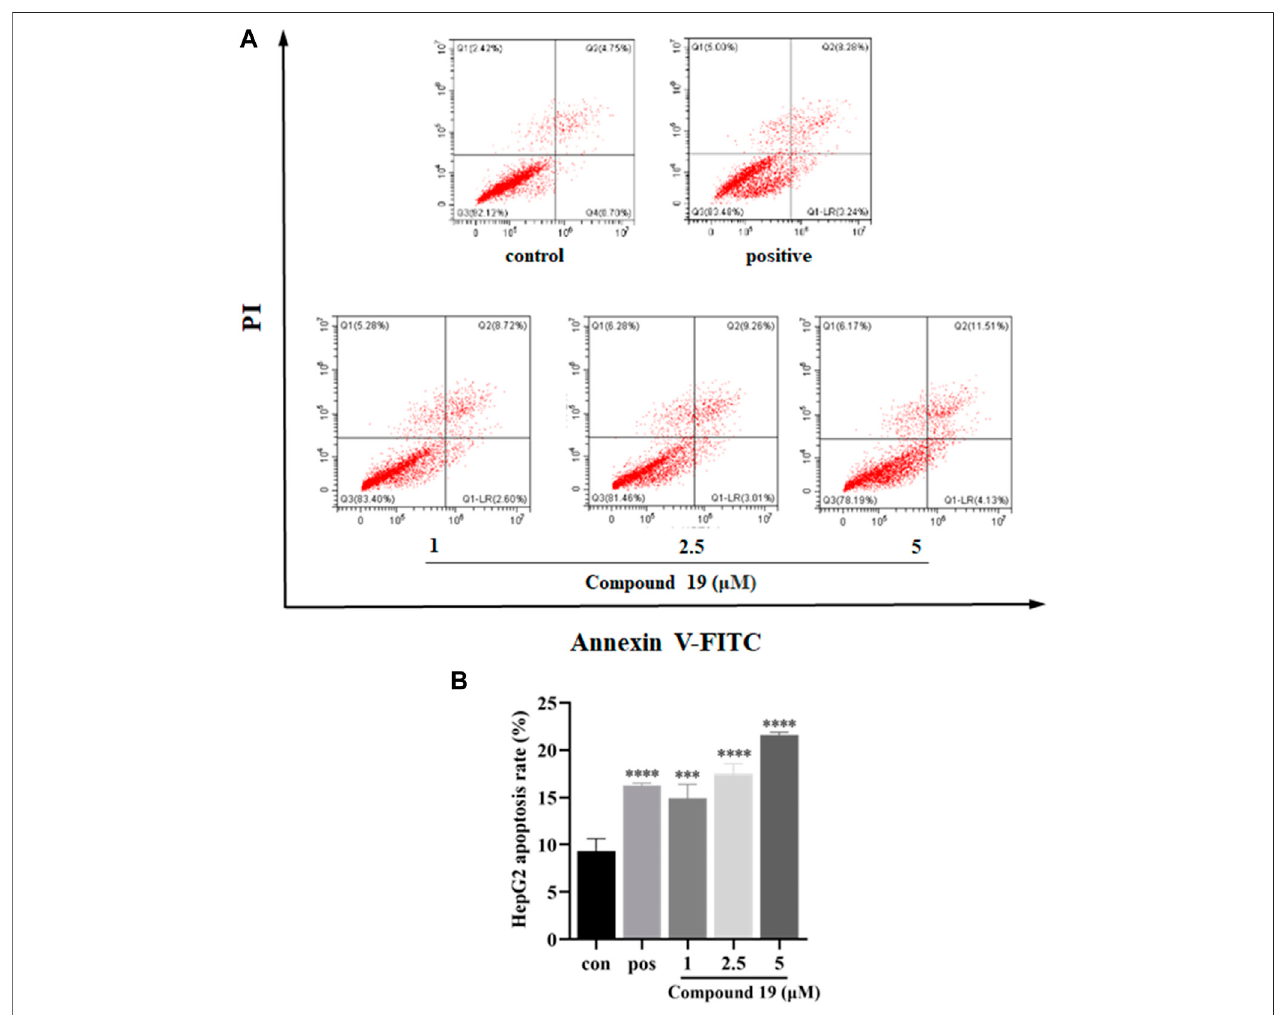
FIGURE5| Impactofcompound 19 onapoptosisofHepG2cells.Cellswereseededin6-wellplates(1×10 6 cells/well)andtreatedwithcompound 19 (1,2.5,and 5 μ M) for 48 h. Gemcitabine (GEM) was used as a positive control. Annexin V-FITC/PI staining fl ow cytometry was used to analyze the apoptosis of HepG2 cells after treatment with compound 19 ; analysis is shown in (A) . The experiments were run in triplicate. Data were presented as mean ± SD. The explicit analysis is shown in (B) . p p < 0.05, pp p < 0.01, and ppp p < 0.001 vs . the control group.